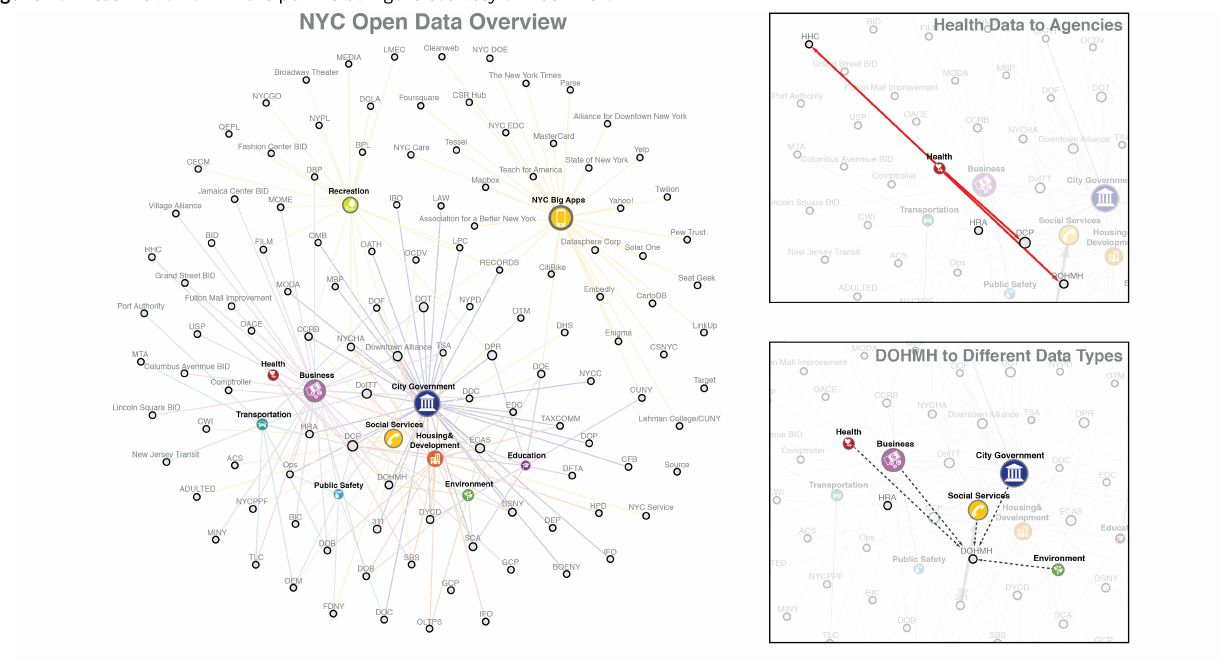
Figure 1. Visualization of NYC Open Data. Figure courtesy of Yuan